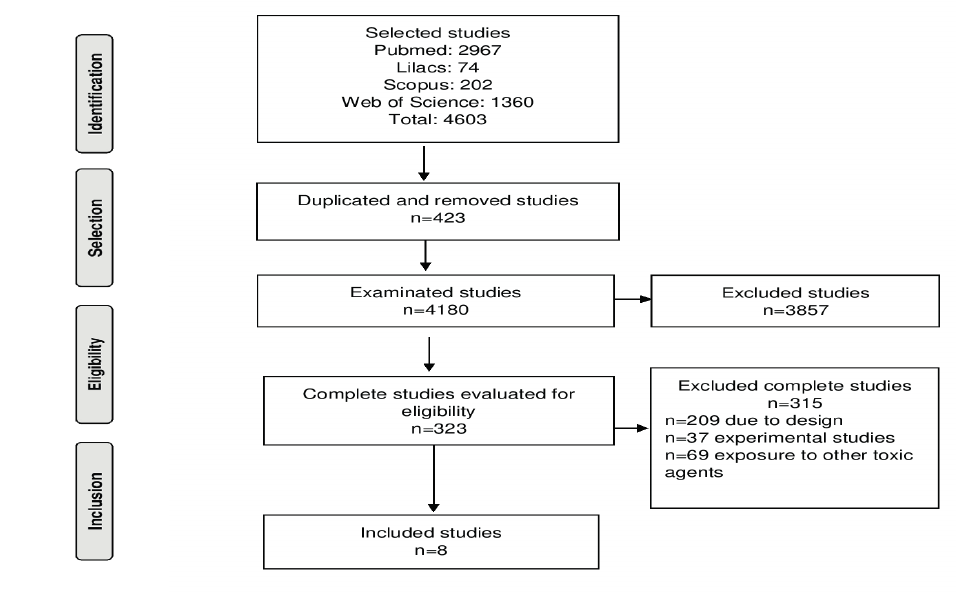
Figure 1 - Flowchart for the studies identified for